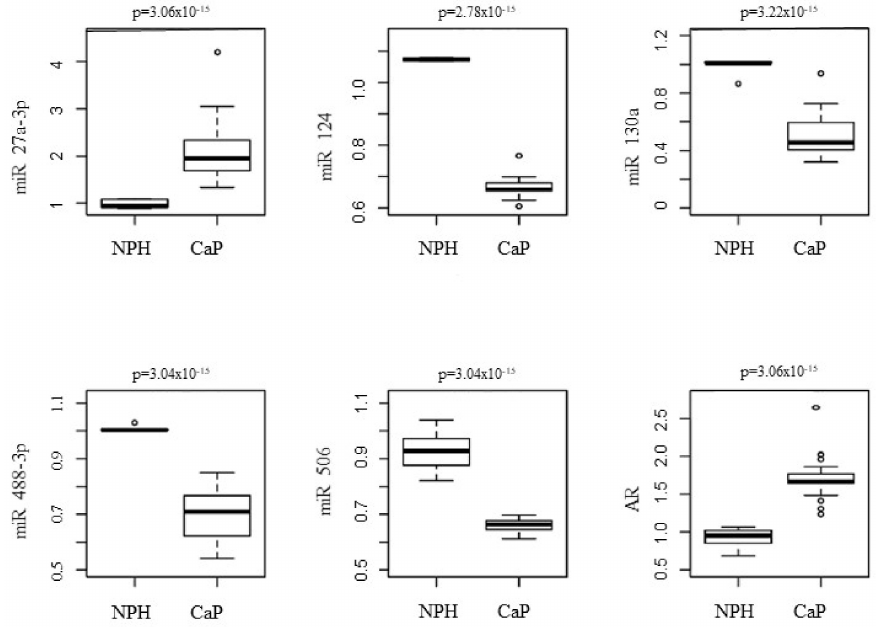
Figure 1. Correlation of the relative prostatic levels of the miRs 27a-3p, 124, 130a, 488-3p, and 506 between the CaP and NPH groups.